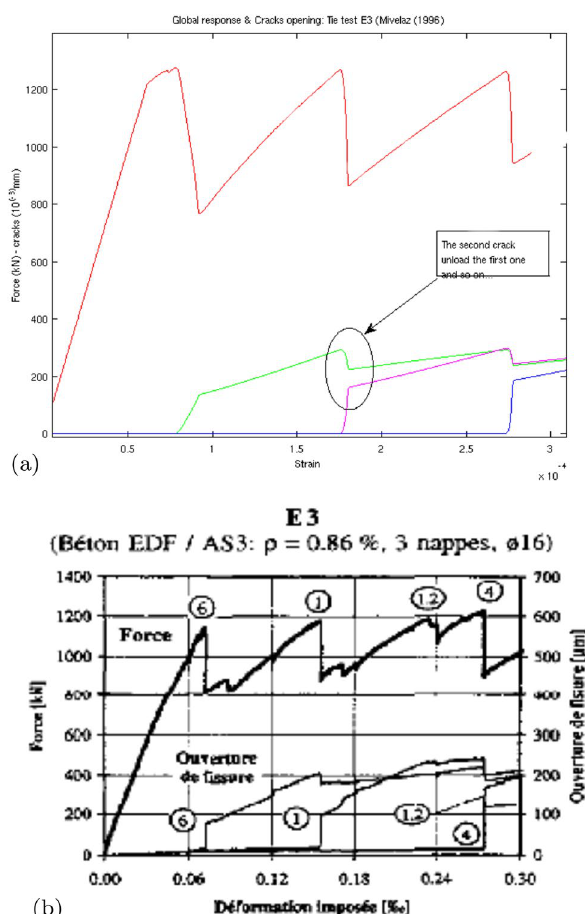
Fig. 21 Électricité de France (EDF) concrete tie-beam test results on force–displacement diagram and crack opening: a computational results with proposed model and b experimental